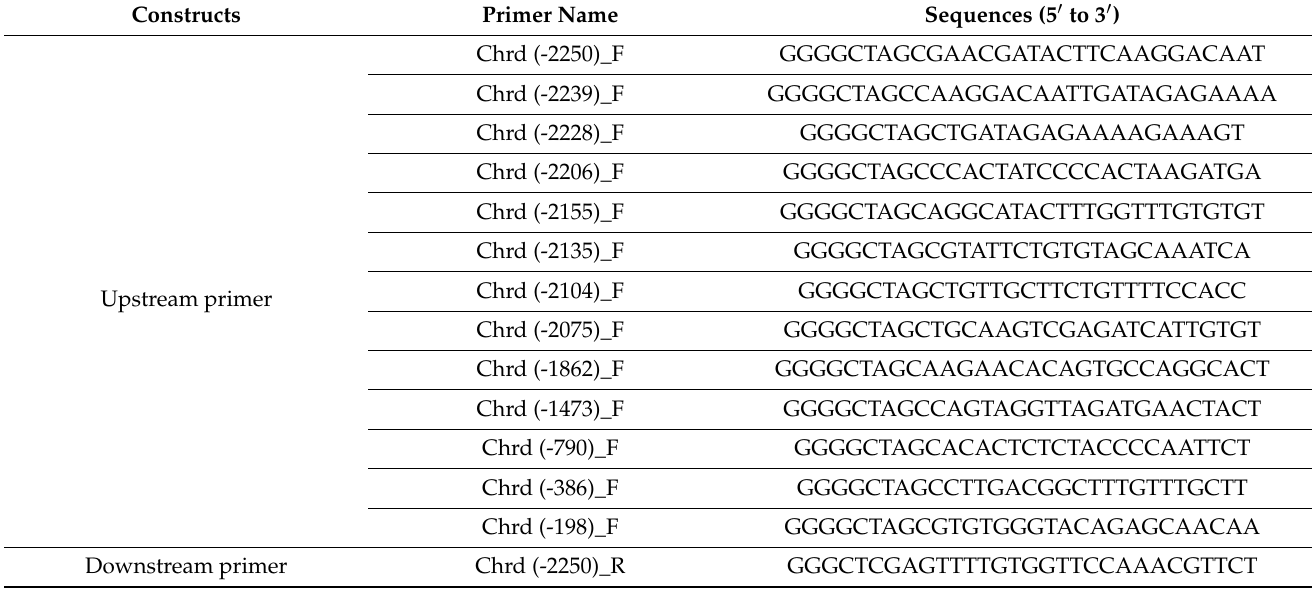
Table 1. Primers used for serially deleted chrd( - 2250) promoter constructs.